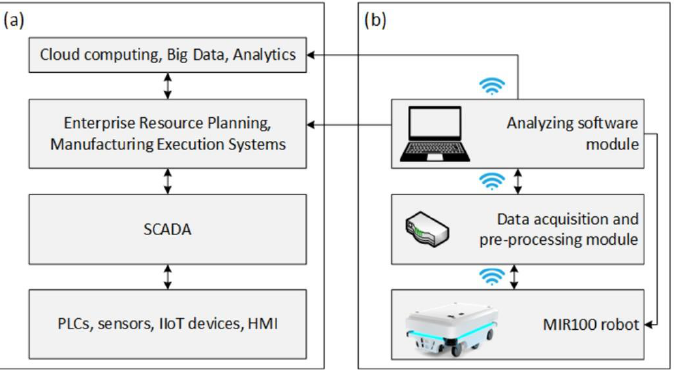
Figure 7. Automation stack and the predictive monitoring system: ( a ) four main levels of automation stack, ( b ) proposed predictive monitoring module for MiR100 robot.